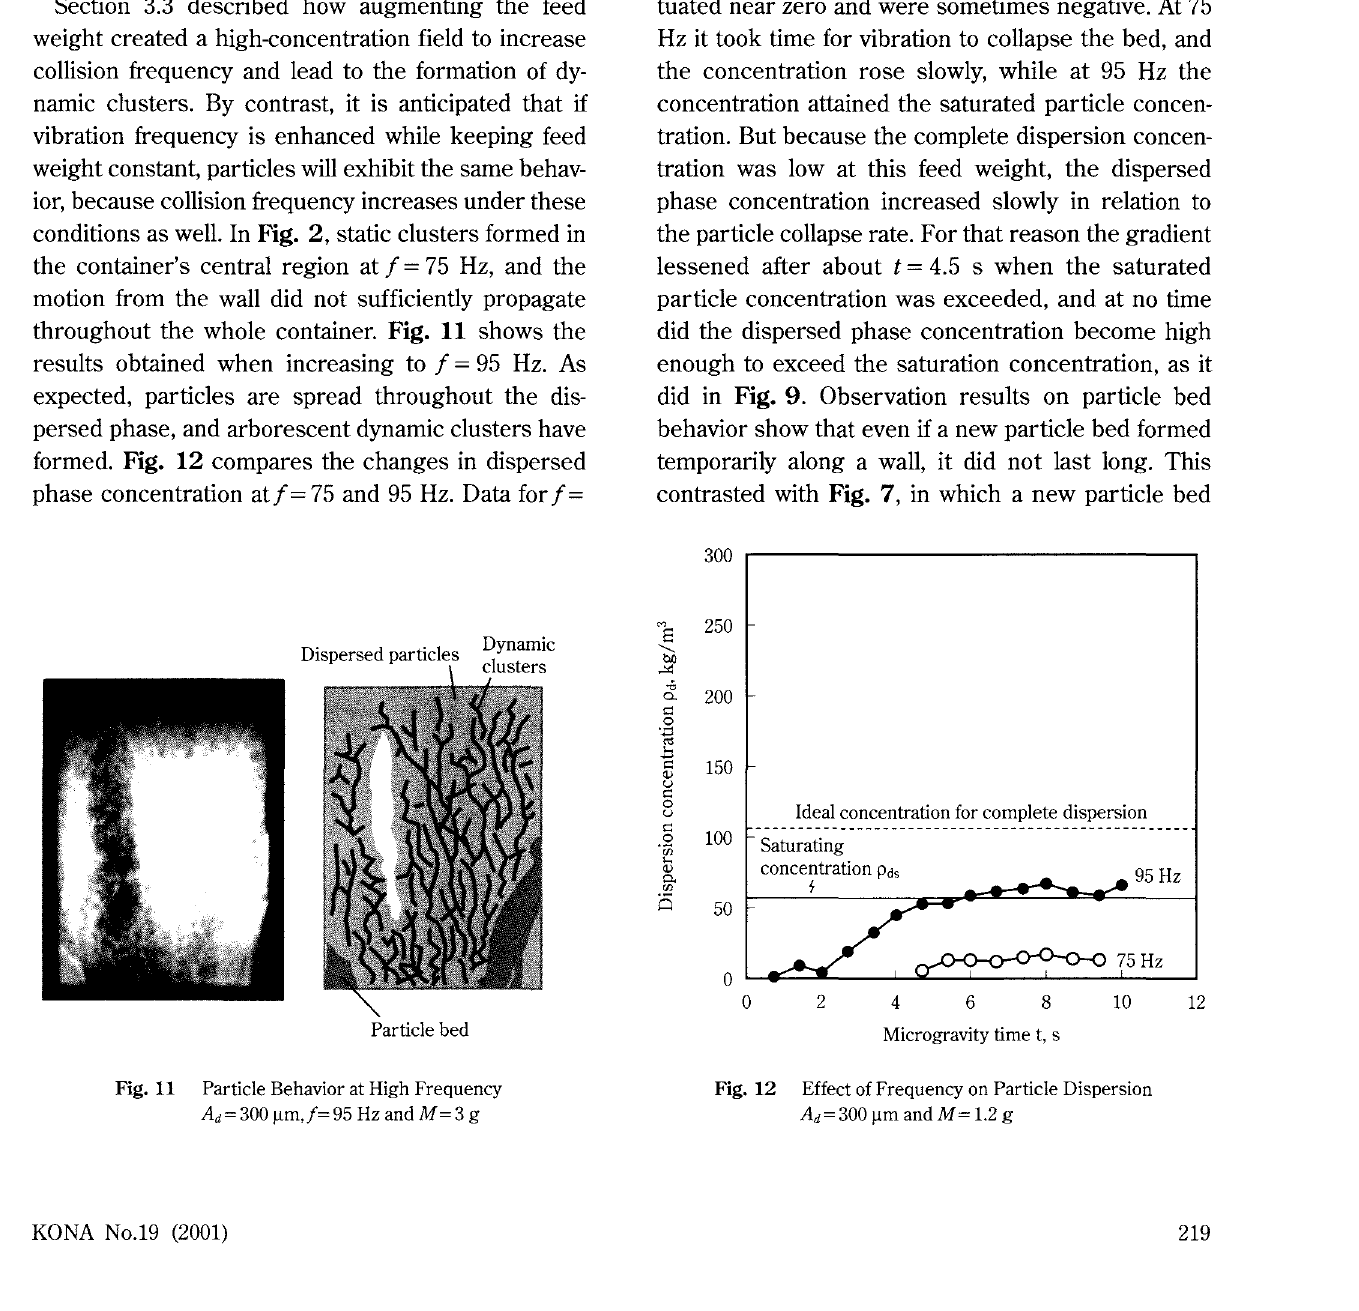
Fig. 12 Effect of Frequency on Particle Dispersion Ad=300 11m andM= 1.2